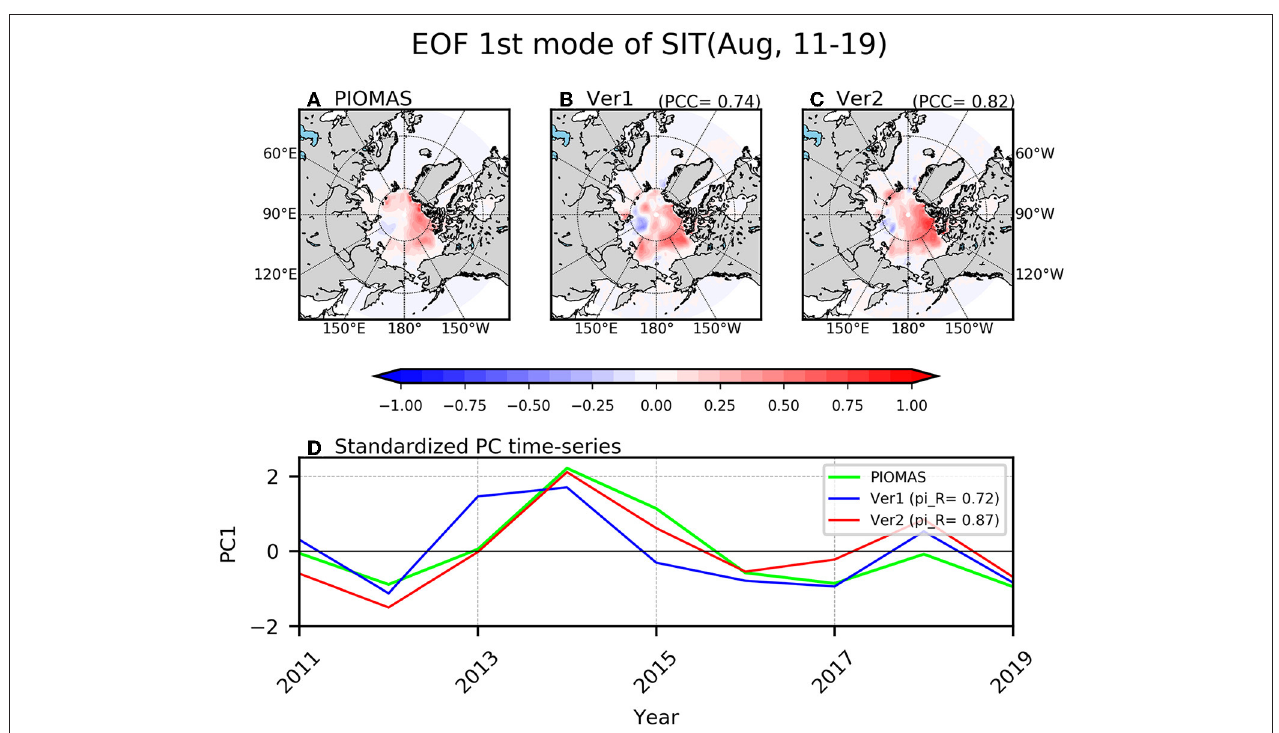
FIGURE 15 | The spatial distribution of the eigenvector of first EOF mode of sea ice thickness for PIOMAS (A) , Ver1 (B) , and Ver2 (C) in August during 2011–2019. The pattern correlation represented “PCC” is calculated between PIOMAS and each experiment. The time-series of the principal component (D) for PIOMAS (light green), Ver1 (blue), and Ver2 (red) is calculated and the “pi_R” represents the correlation coefficients with PIOMAS reanalysis